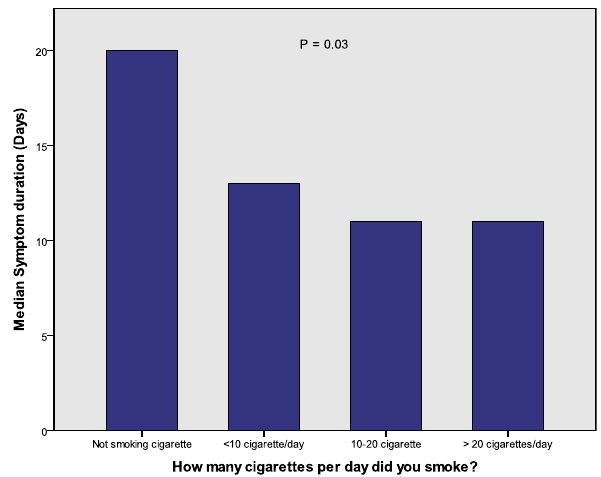
Figure 5: Comparison of the symptom duration between groups with di ff erent amounts of cigarette